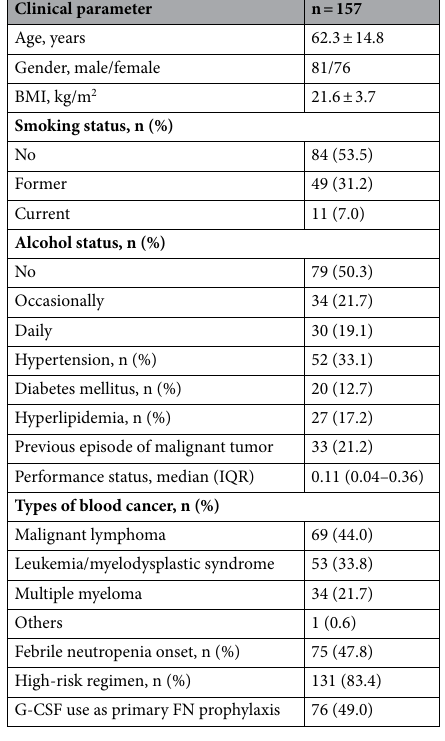
Table 1. Baseline clinical characteristics of patients in this study. IQR, interquartile